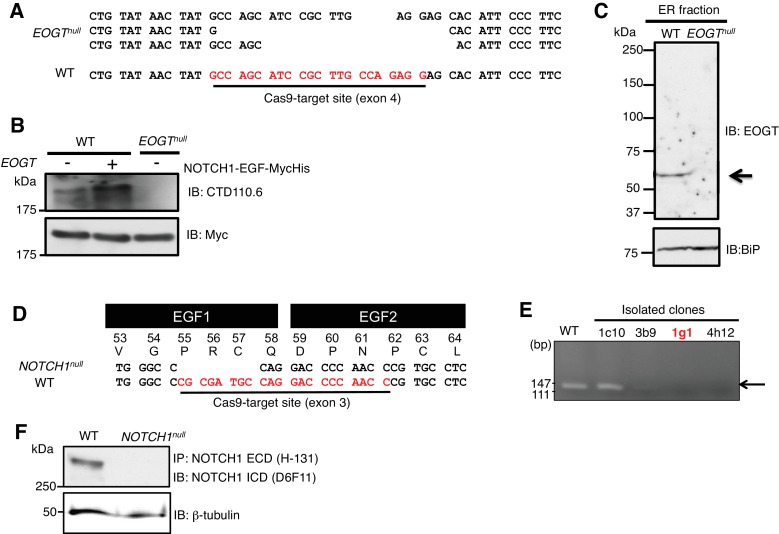
Generation and characterization of EOGT- and NOTCH1-null HEK293T cells.(A) Schematic diagram of the CRISPR/Cas9 genome editing strategy to generate EOGT-null HEK293T cells. CRISPR/Cas9-mediated DNA cleavage caused frameshift mutations in all three EOGT alleles in HEK293T cells. (B) Wild type or EOGT-null HEK293T cells with Notch1-EGF-mycHis alone or together with EOGT. CTD110.6 immunoblotting revealed the lack of O-GlcNAc on NOTCH1 EGF repeats in the absence of EOGT. (C) Total ER fraction was obtained using Endoplasmic Reticulum Enrichment Extraction Kit (Novus Biologicals [NBP2-29482]) from parental HEK293T cells or EOGT-null cells, and subjected to immunoblotting with EOGT (1:2000 dilution) or BiP (1:10000 dilution) antibodies. (D) Schematic diagram of the CRISPR/Cas9 genome editing strategy to generate NOTCH1-null HEK293T cells. CRISPR/Cas9-mediated DNA cleavage caused frameshift mutations in the single NOTCH1 allele in HEK293T cells. (E) Screening for CRISPR/Cas9-mediated genomic deletion at the Notch1 locus. A clone 1g1 was selected and deletion of the target sequence was confirmed by direct sequencing analysis. (F) Total cell lysates from parental HEK293T cells or NOTCH1-null cells were subjected to immunoprecipitation (IP) using NOTCH1 ECD antibody (H-131). The immunoprecipitates were analyzed by immunoblotting with NOTCH1 ICD antibody (D6F11). Aliquots of total cell lysates were immunoblotted with β-tubulin antibody.